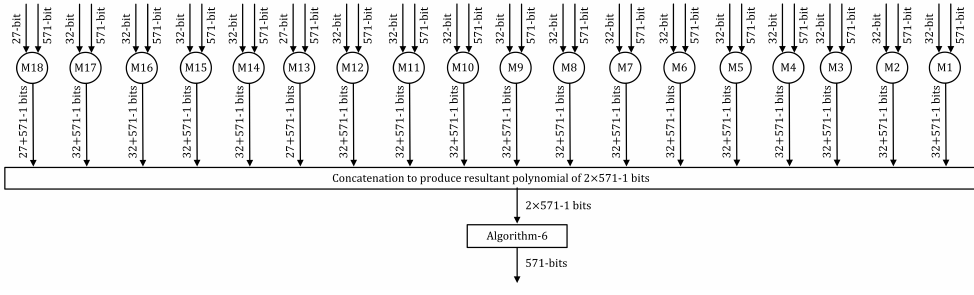
Figure 6. Least significant digit-parallel multiplier over GF ( 2 571 )